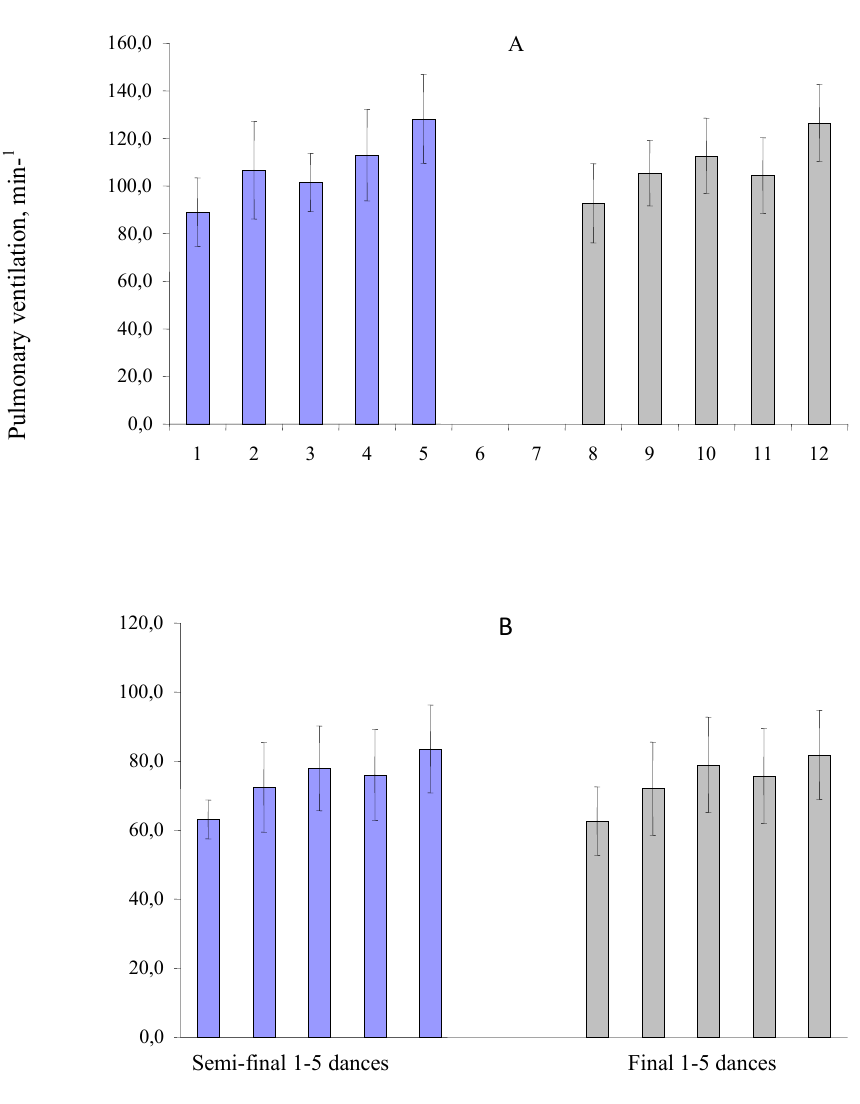
Fig.2. Changes of pulmonary ventilation in the process of competition functioning’s simulation in semi-final and final; (А) men and (B) – women: - differences are not statistically